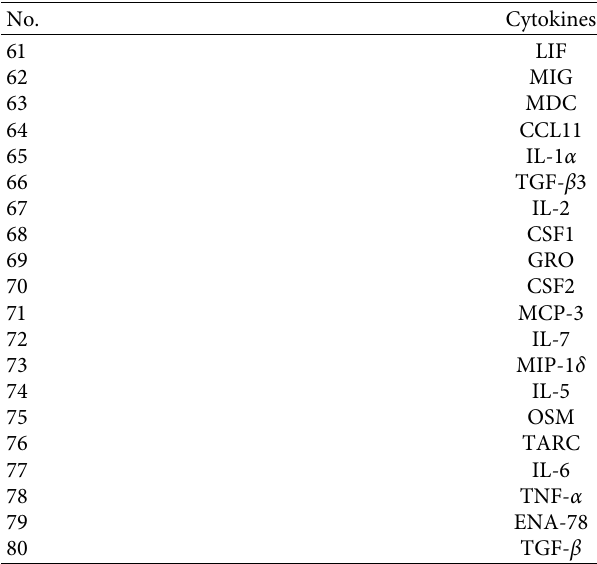
Table 2: Cytokine array G5 cytokine